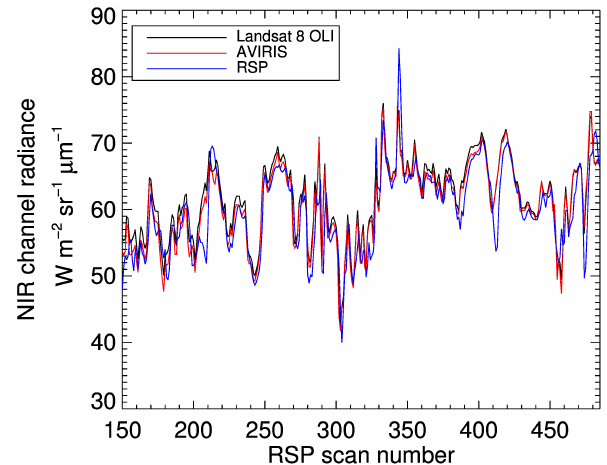
Figure 6. The signal of OLI, AVIRIS, and RSP along the line formed by locations of RSP nadir measurements. The OLI and AVIRIS imagery was spatially averaged to match the RSP footprint. The AVIRIS spectrum was band-averaged to match RSP channel